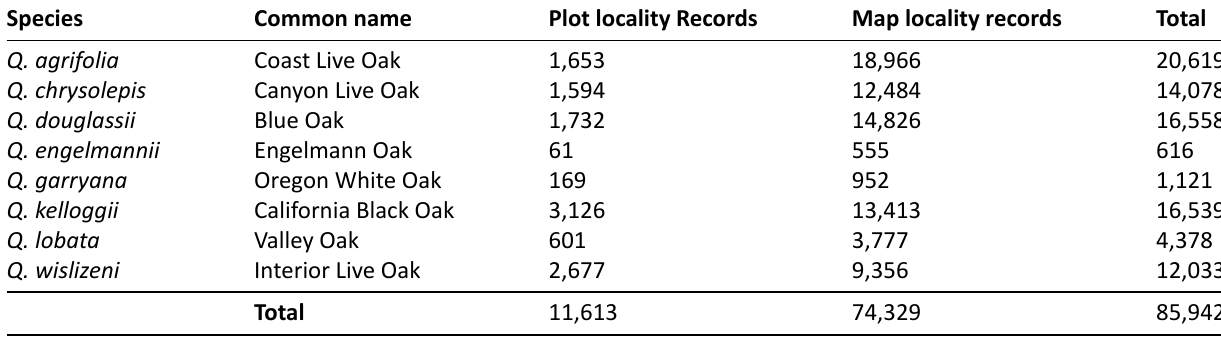
Table 1. VTM dataset sample sizes used in species distribution modeling for eight California oak species.